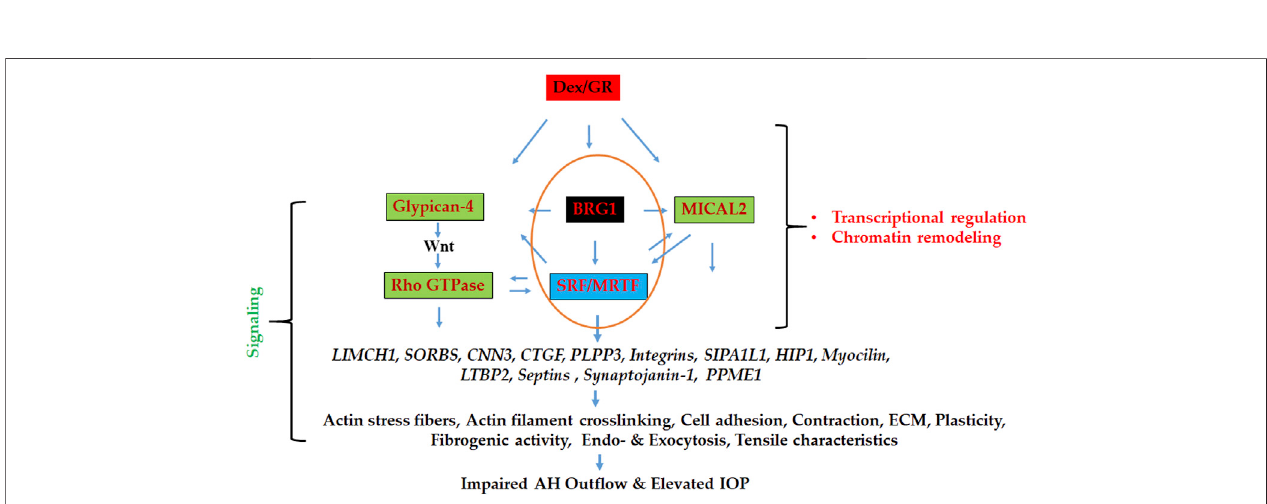
FIGURE 9 | Schematic illustration of the mechanisms involved in regulating the expression of actin cytoskeletal network, contractile, cell adhesive, and vesicle traf fi cking proteins inDextreatedTMcells.BRG1(regulatorofchromatin remodeling),MICAL2(regulatorofnuclearactin depolymerization),and Glypican-4(regulatorof Wnt/PCPsignaling) dependent pathways appear tocollectively in fl uence geneexpression via stimulating SRF/MRTF-A transcriptionalactivity (aknownmasterregulator of actin cytoskeletal and contractile protein expression) under these conditions, thereby playing a potential role in modulation of aqueous humor out fl ow and intraocular pressure. GR: Glucocorticoid